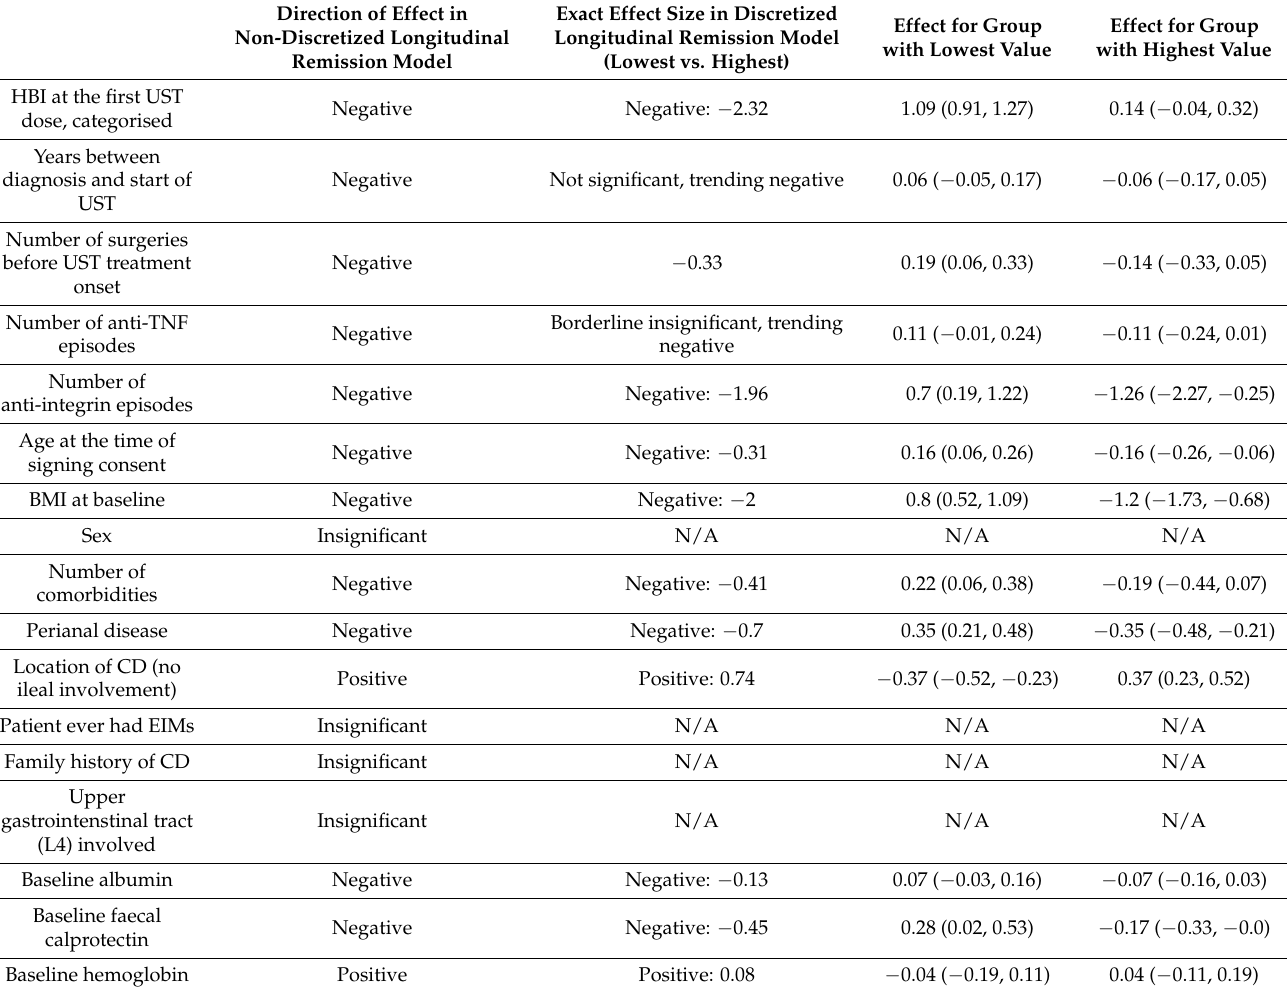
Table 3. Estimated effects of each variable on longitudinal